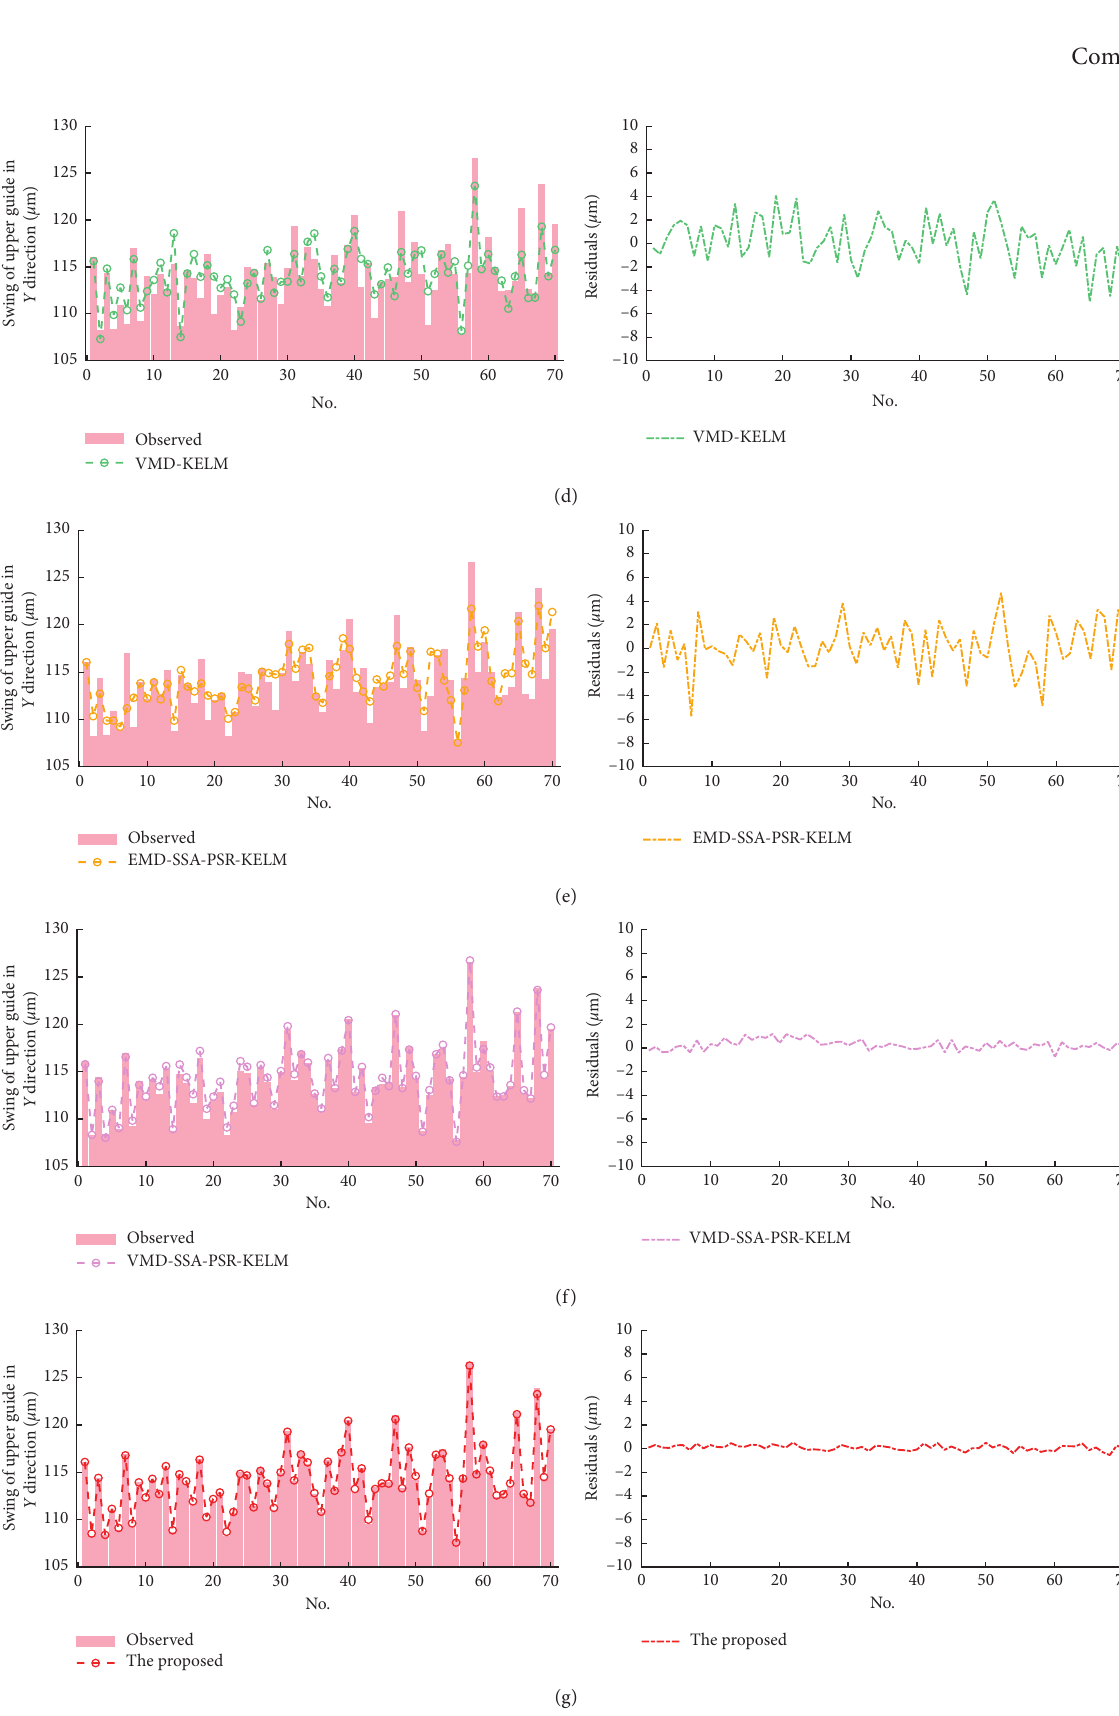
Figure 9: The forecasting results of various experimental models: (a) SVR, (b) KELM, (c) EMD-KELM, (d) VMD-KELM, (e) EMD-SSA- PSR-KELM, (f) VMD-SSA-PSR-KELM, and (g) the proposed